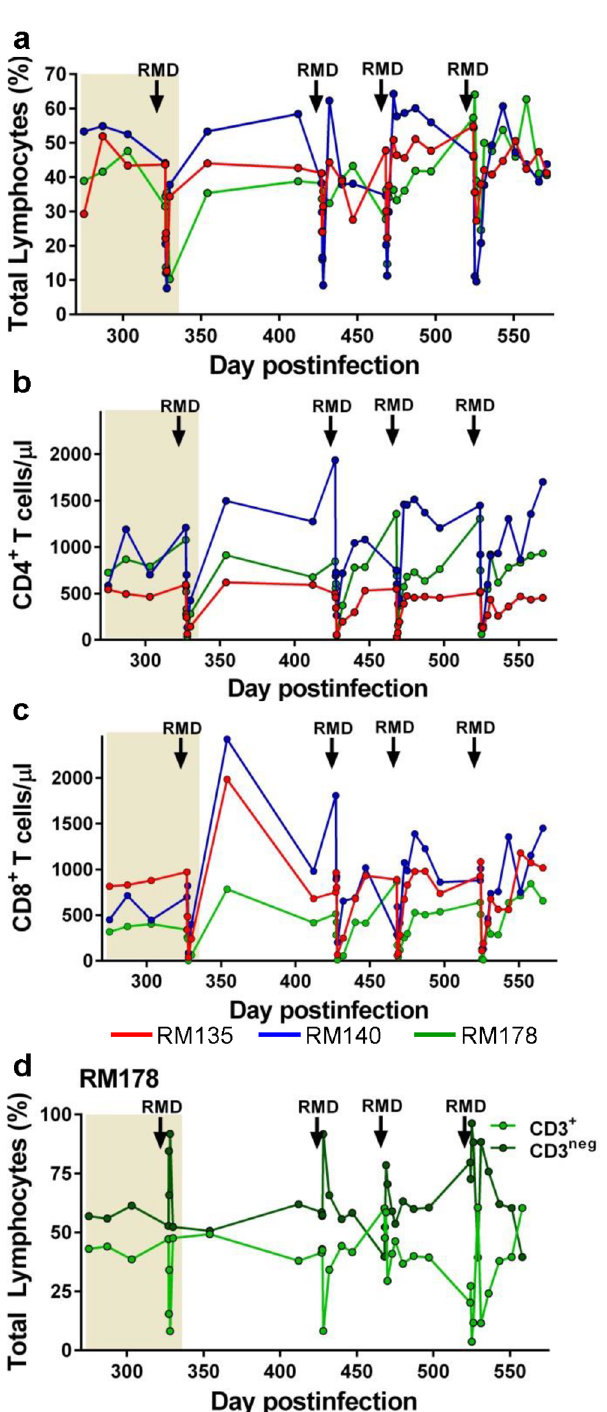
Fig 6. Effect of RMD administration on the peripheral blood major T cell subsets. (a) The levels of the total lymphocyte population (as measured by the Trucount assay) dramatically, but transiently, decrease after each round of RMD administration, resulting in similarly dramatic decreases of both CD4 + T cell (b) and CD8 + T cell (c) counts. (d) Comparative analysis of the CD3 + and CD3 neg populations showed that the reduction in the CD3 + T cell counts was mirrored by a dramatic surge in the population of CD3 neg lymphocytes, suggesting the significant reduction in the lymphocyte counts were due to a downregulation of surface markers rather than a real depletion of cells. ART administration is highlighted as a light orange box in the graphs. Time of the RMD administration is illustrated with black arrows.